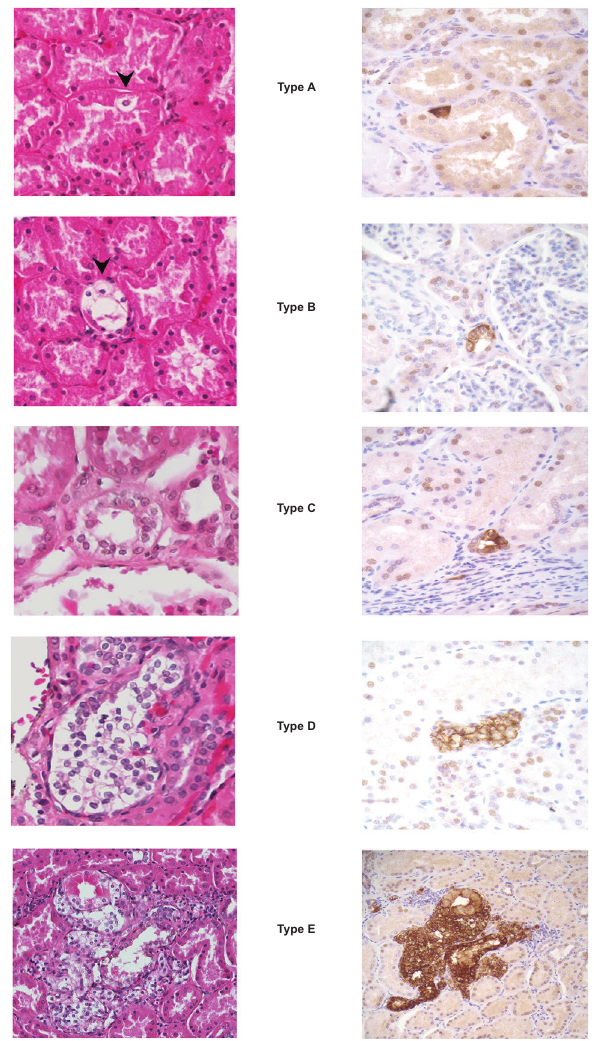
Figure 3: Most frequently observed pathologic events in VHL kidney. Events can be identified on H&E-stained sec- tions (left) or by immunohistochemistry for CAIX (right). Representative samples of sections unrelated to each other are shown. Type A, single clear cell; type B, small chain of clear cells; type C, large chain of clear cells; type D, intratu- bular clear cell cluster; type E, invasive clear cell cluster.